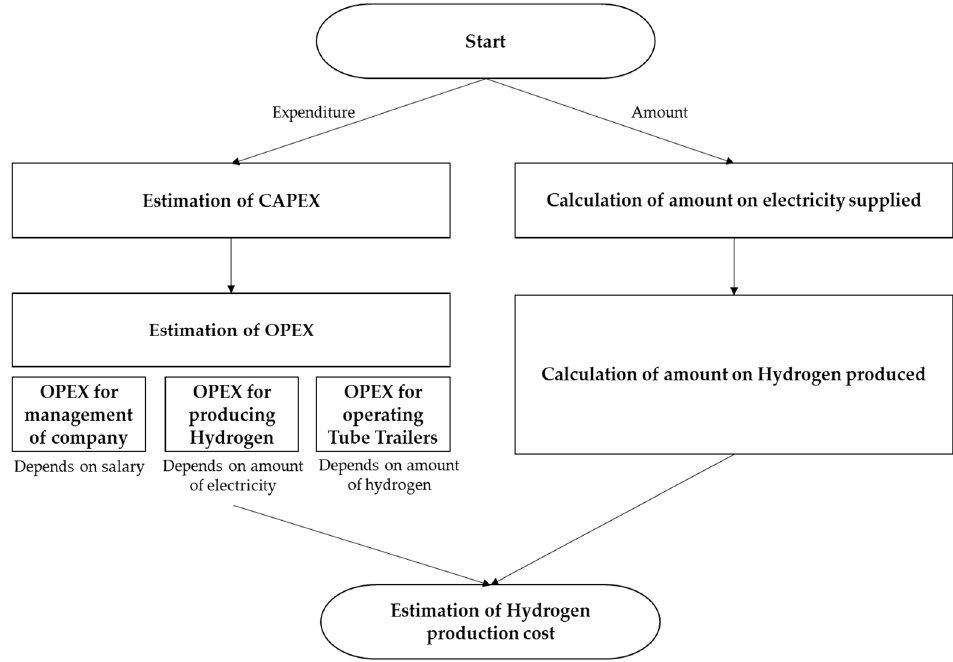
Figure 2. Procedure for estimating hydrogen cost.